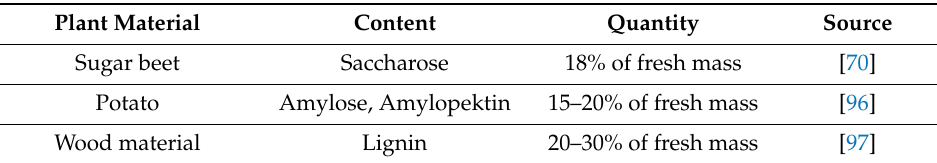
Table 1. Industrially produced primary plant ingredients.